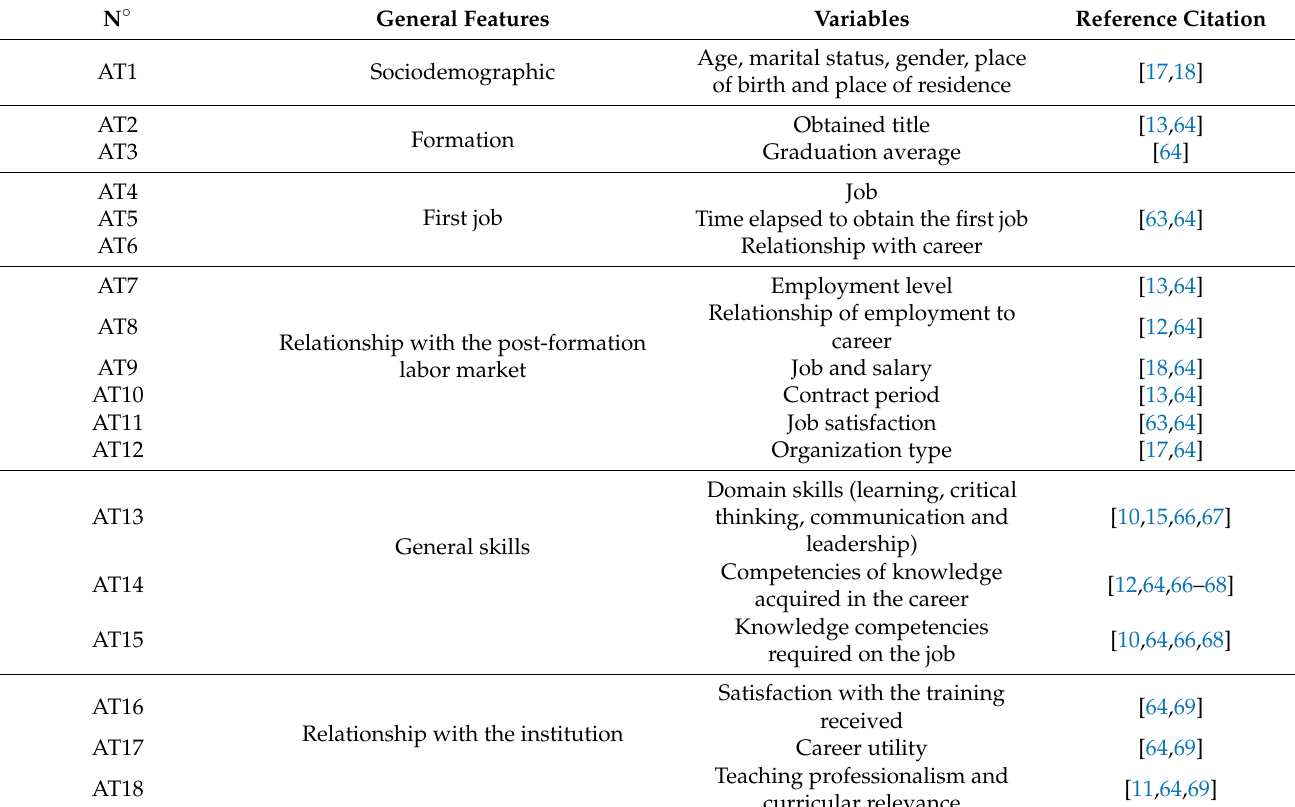
Table 1. Parameters of the alumni tracking.